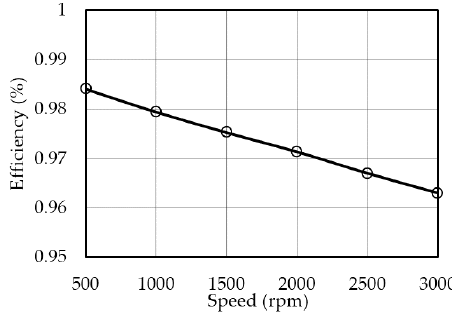
Figure 23. Efficiency of the converter.